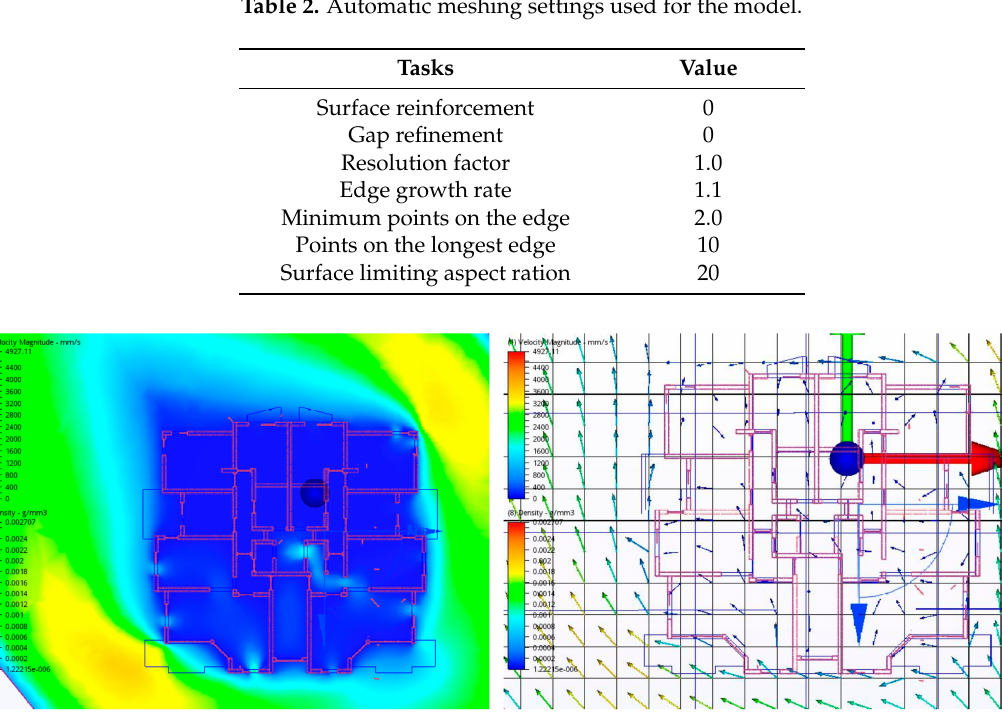
Table 2. Automatic meshing settings used for the model.